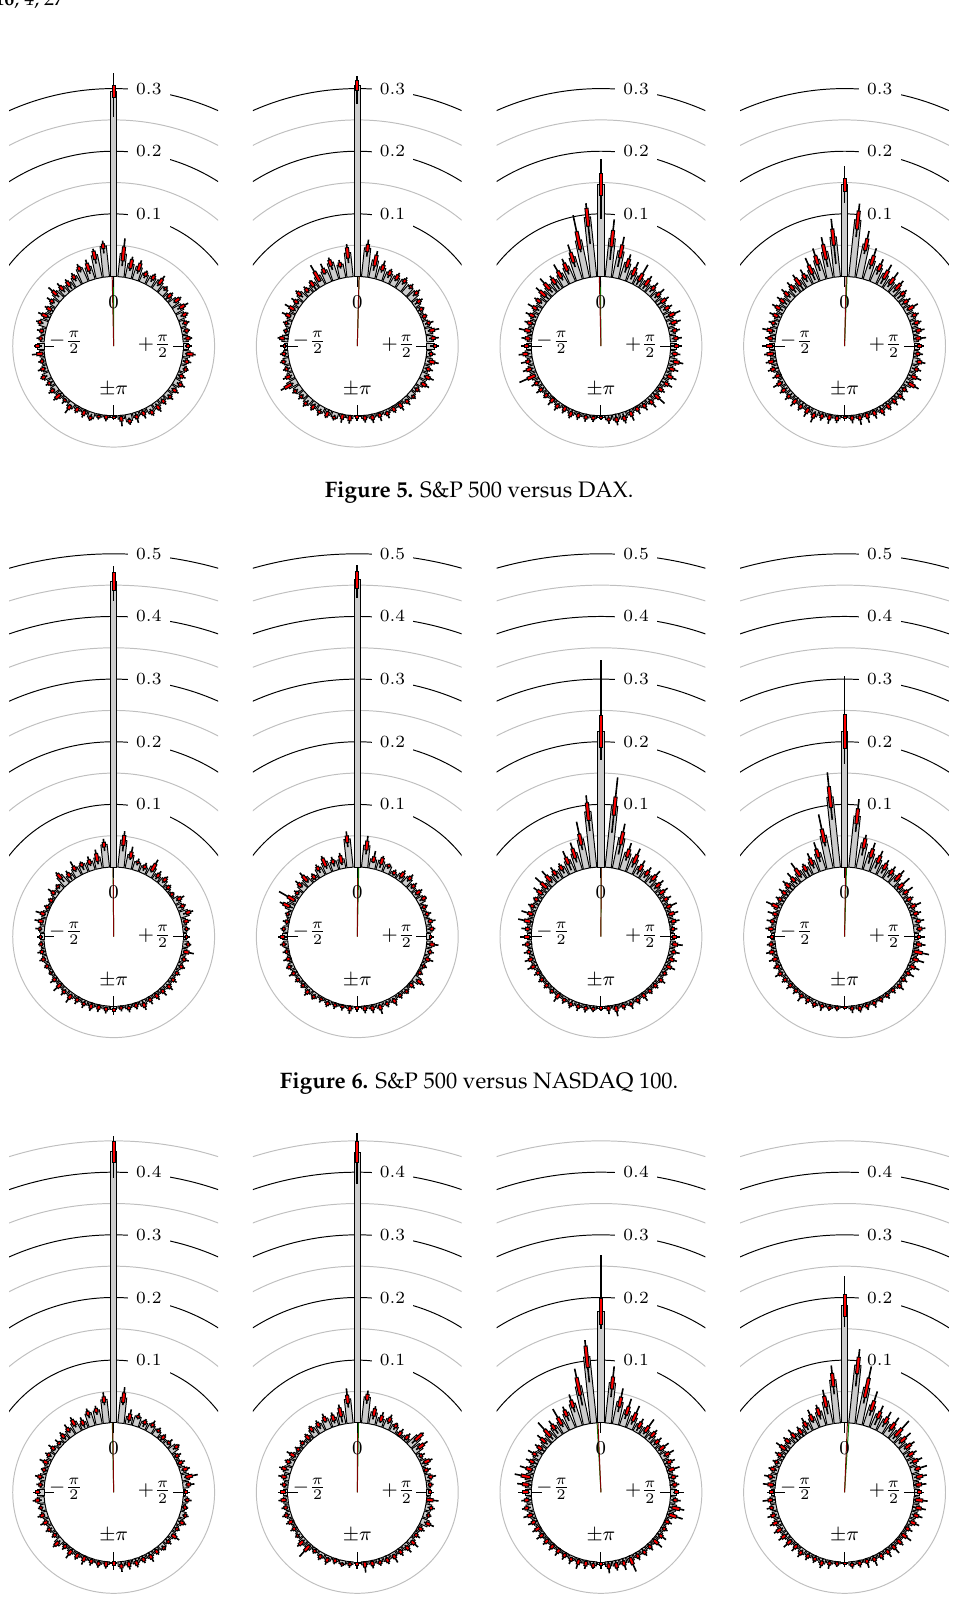
Figure 7. S&P 500 versus Russell